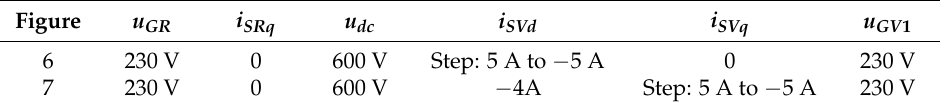
Figure 5. Phase current control experimental result. CH1: i SV 1 , 10 A/div, 20 ms/div; M: i SV 1 frequency spectrum, 100 mA/div, 1.25 kHz/div. Table 3. Operation conditions of Figures 6 and 7. Table 3. Operation conditions of Figures 6 and 7.